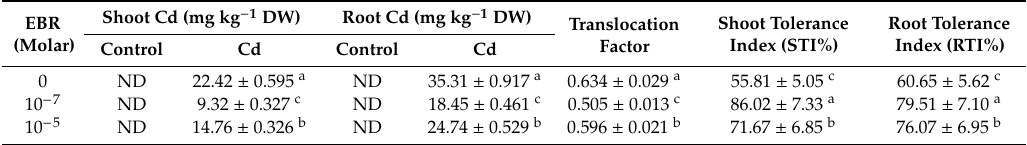
Values with di ff erent letters are significantly di ff erent at each measured time point ( p < 0.05). ND = not